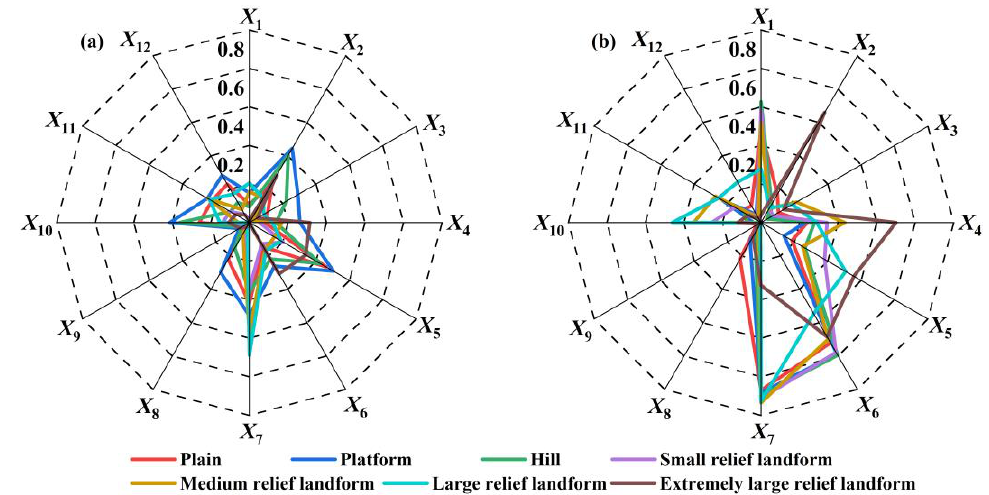
Figure 8. The q values of driving factors in different geomorphic types in ( a ) the daytime and ( b ) the nighttime.